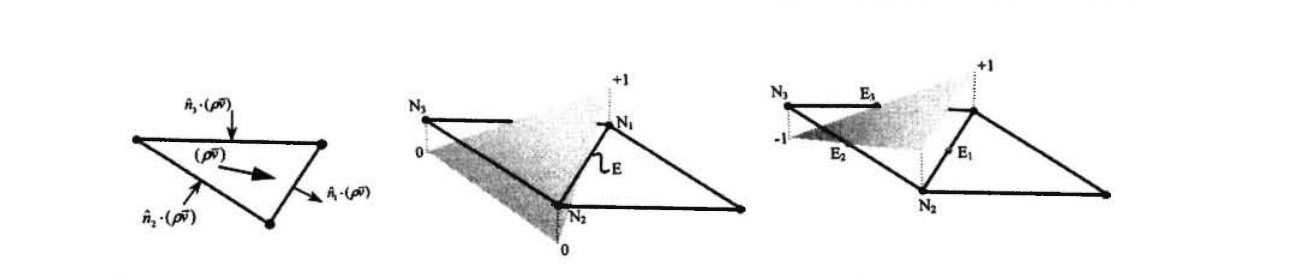
Fig. 2: Triangular finite element: (a) incoming and out-coming flows in the FE; (b) conforming shape function at node N|; (c) non-conforming shape function associated to edge